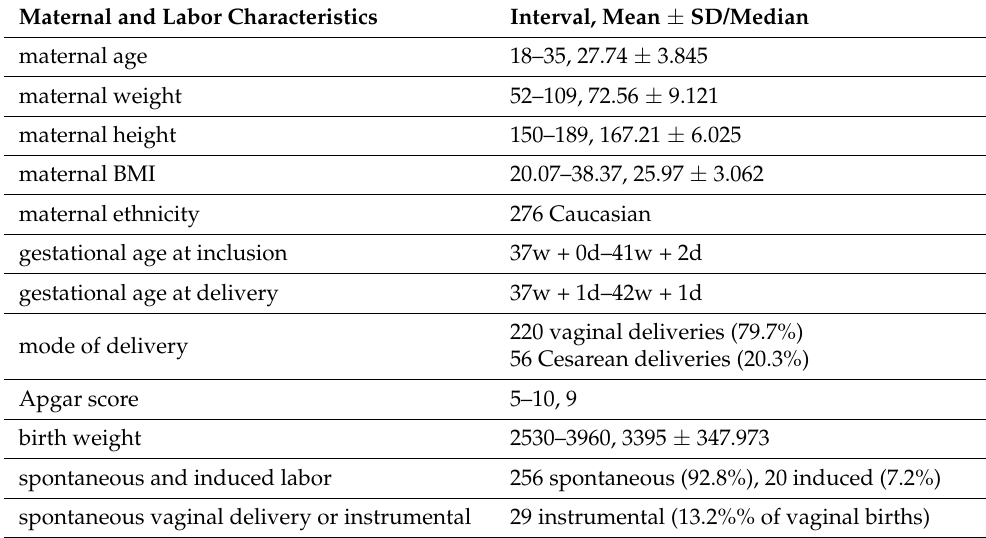
Table 1. Characteristics of study population of 276 nulliparous women at term and labor outcome.